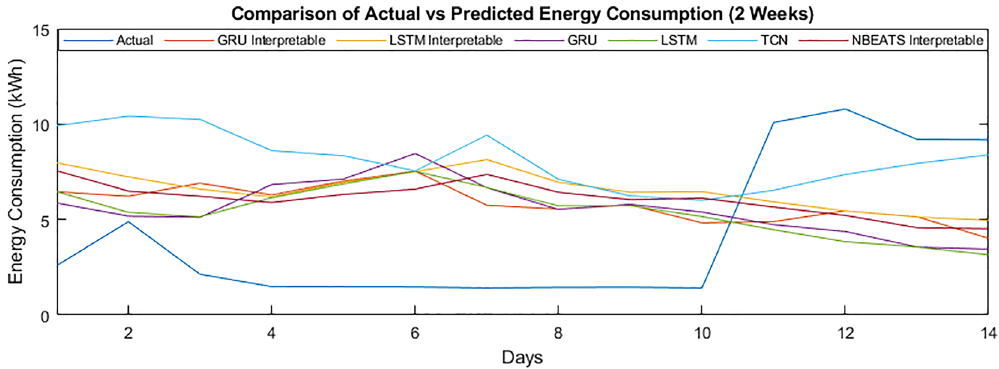
Figure 7. Comparison of actual vs predicted energy consumption (2 weeks).